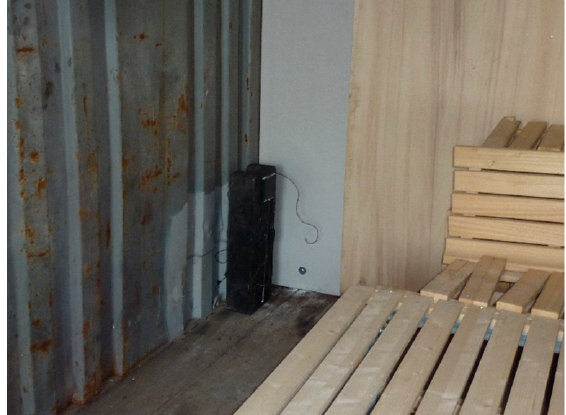
Figure 7. Hot–plate thermometer located in the corner (configuration C1). Figure 7. Hot-plate thermometer located in the corner (configuration